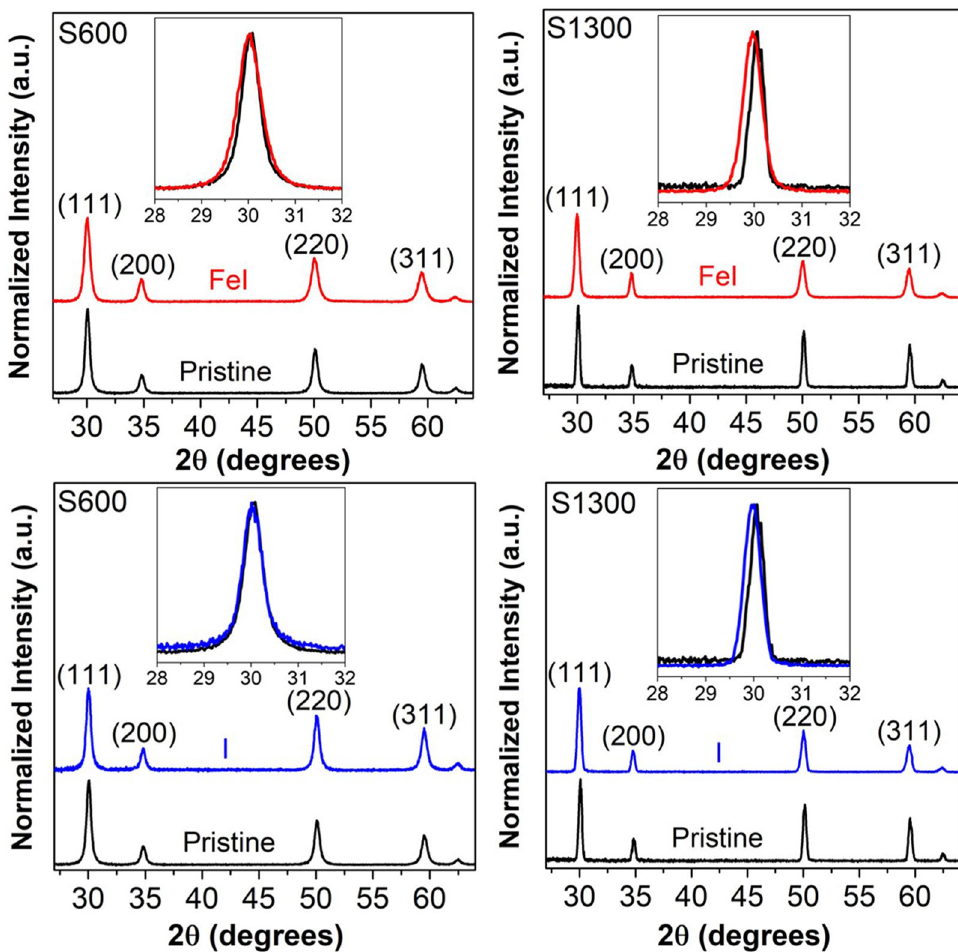
Figure 2. GIXRD patterns of pristine and irradiated S600, S1300. The top row corresponds to the simultaneous irradiations (FeI), bottom row corresponds to the single beam (i.e., only I) irradiations. Magnified view of the (111) peak for all samples is shown as inset.